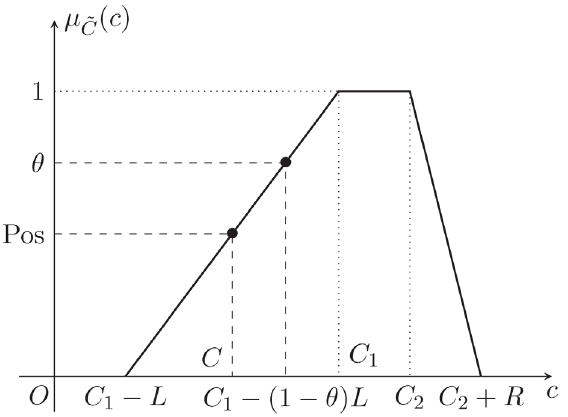
Figure 5. Treatment of objective: possibility-fractile approach.